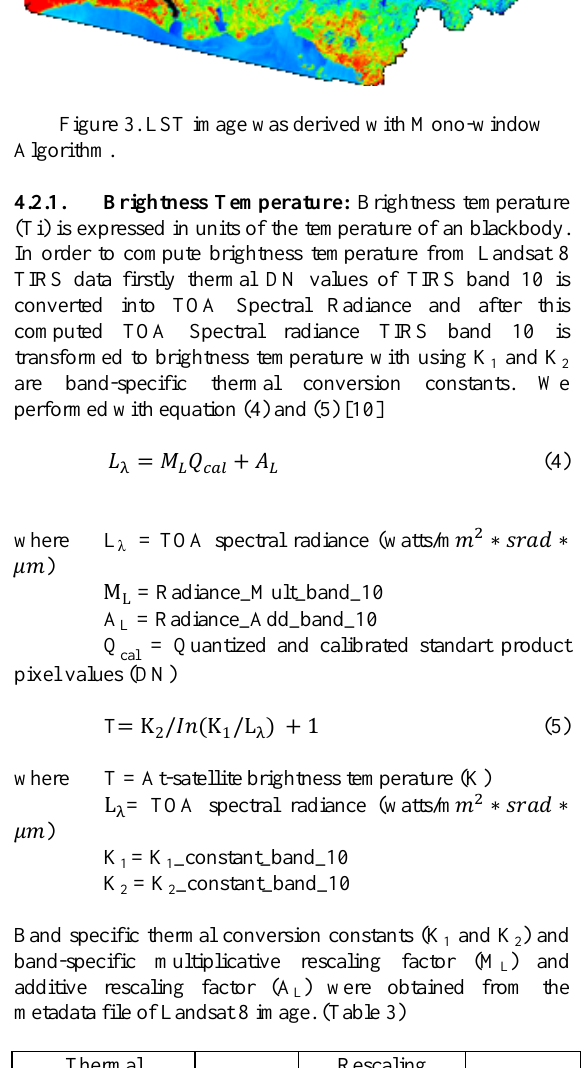
Table 4. Lineer relation equations between effective mean